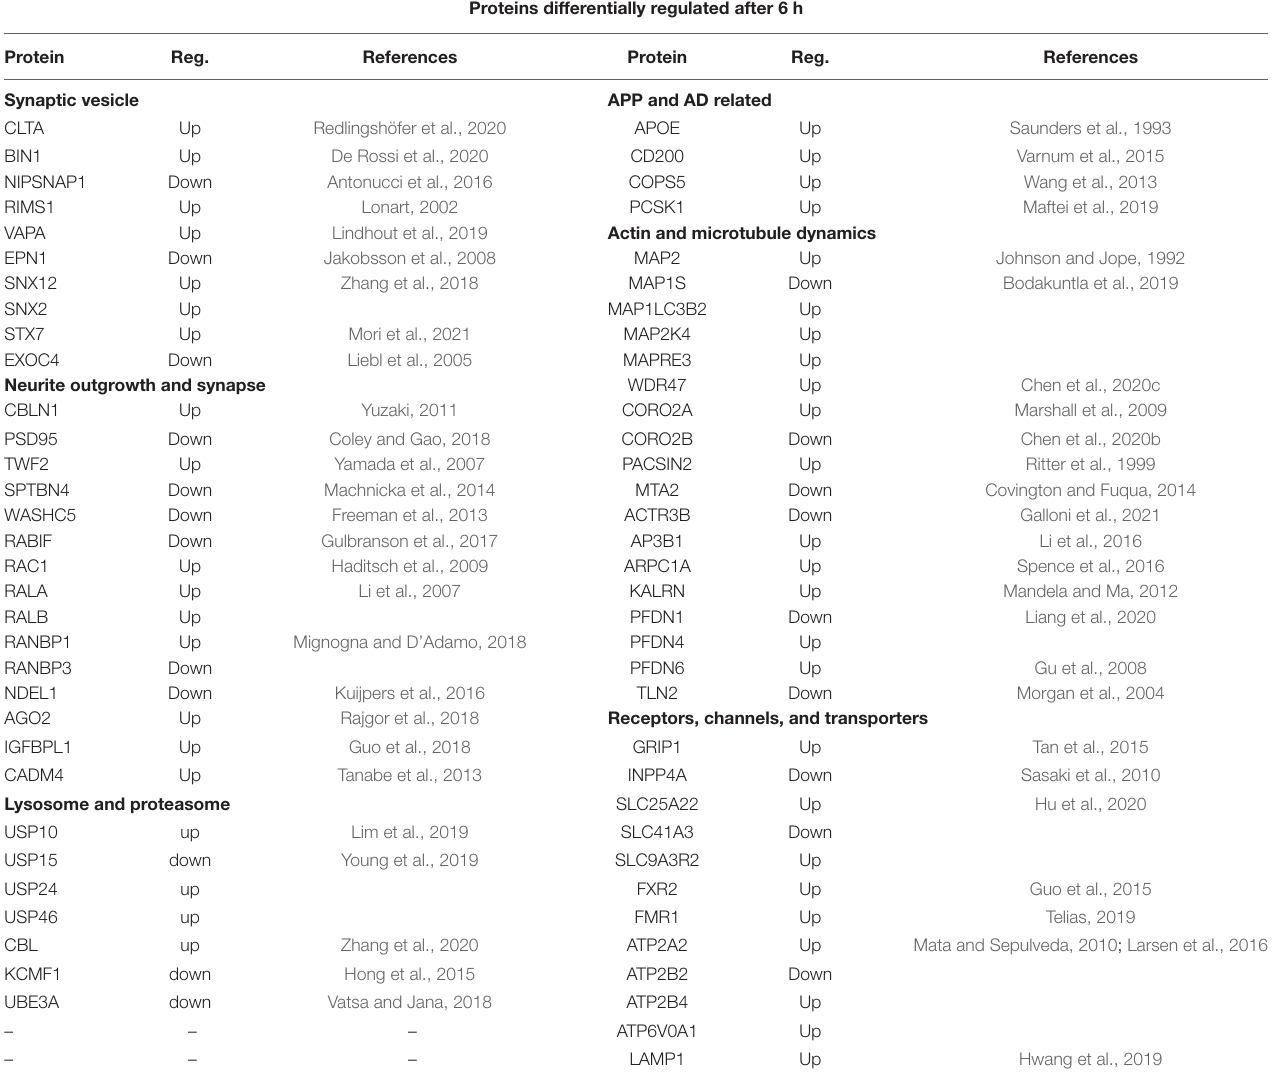
Proteins differentially regulated after 6 h